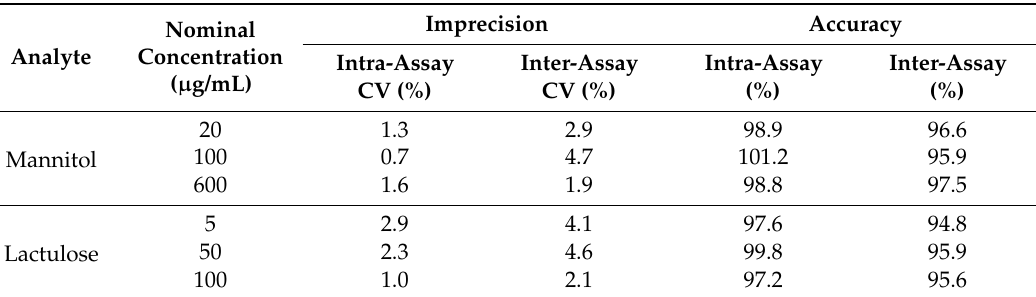
Table 1. Validation